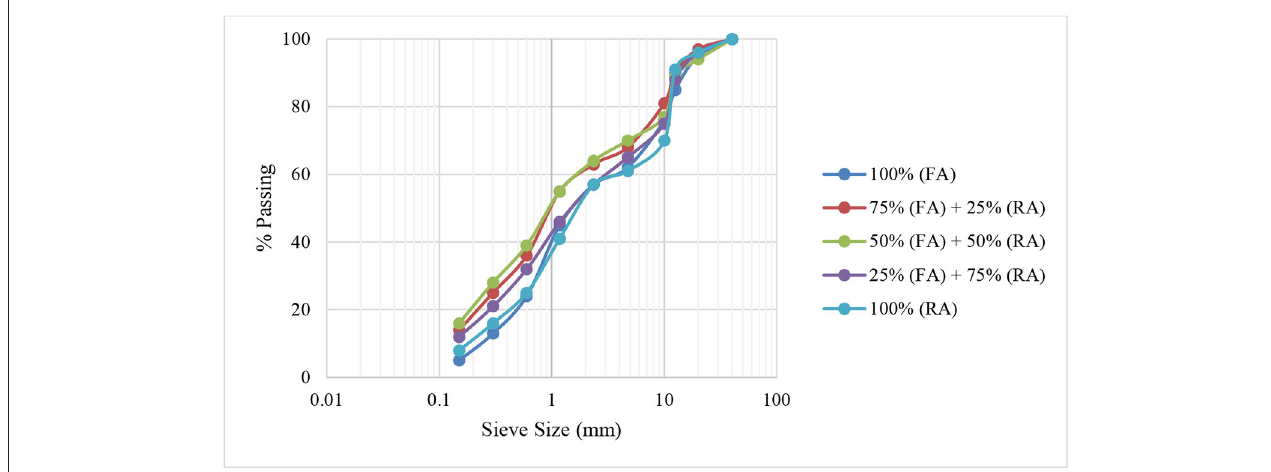
FIGURE3 Recycled aggregate particle size-distribution curves at different percentages of replacement.